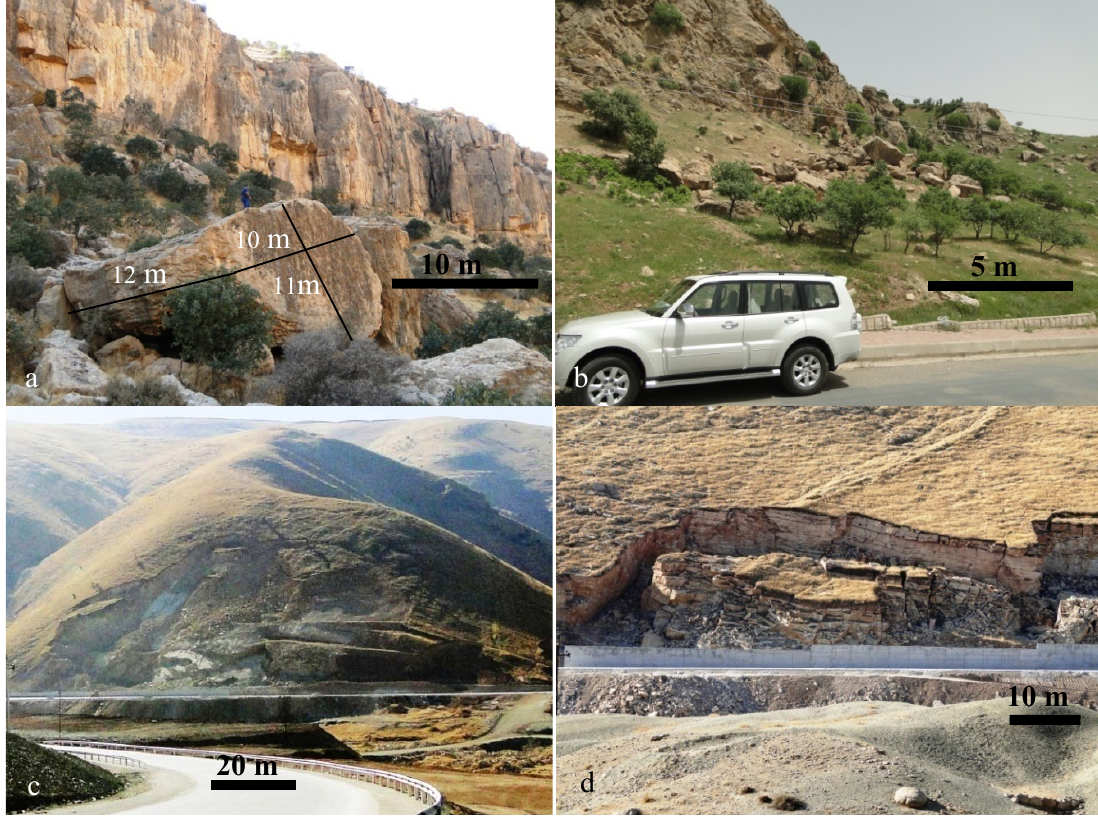
Figure 4. Typical examples of landslides within the study area. ( a , b ) Rock fall in station S1 and S2; ( c , d ) Rock slide in the study area near Dukan Lake at station S3.